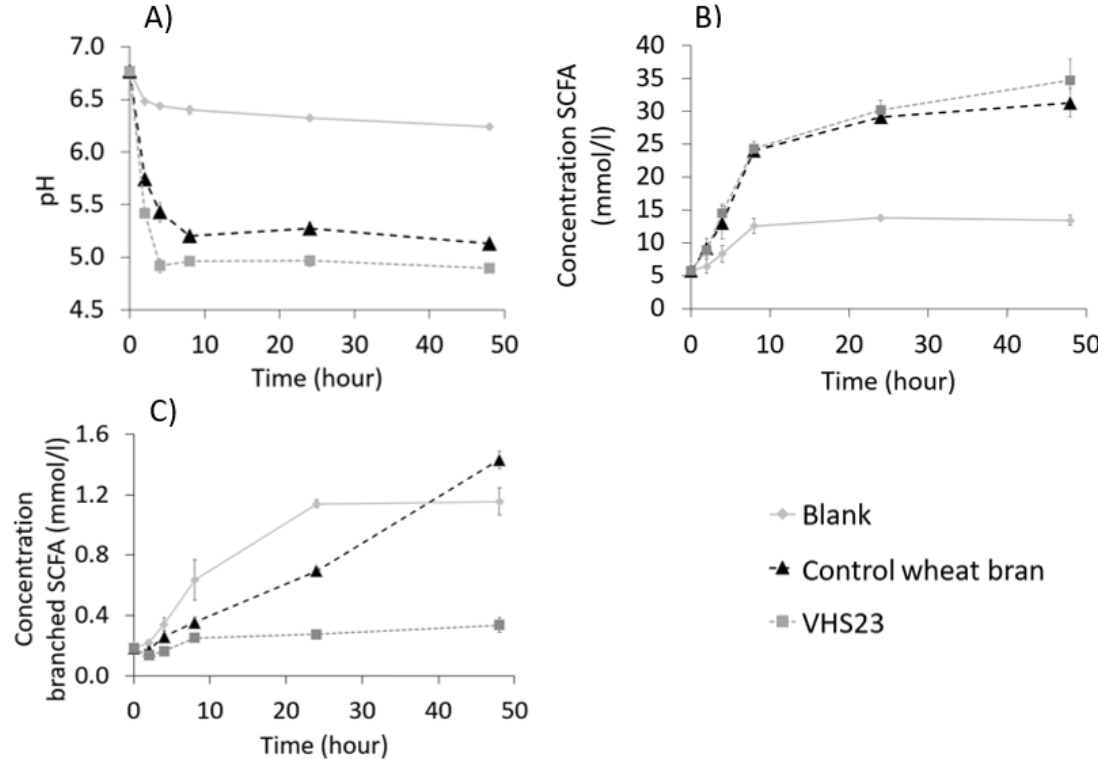
Figure 6. ( A ) pH, ( B ) concentration of short-chain fatty acids (SCFA) (sum of acetate, propionate, butyrate, isobutyrate, isovalerate; mmol/L) and ( C ) concentration of branched SCFA (isobutyrate and isovalerate, mmol/L) as a function of time obtained during an in vitro fermentation experiment in a 10% faecal slurry of a blank sample (no bran addition), control wheat bran and very high shear extruded wheat bran at 23% of moisture (VHS23).